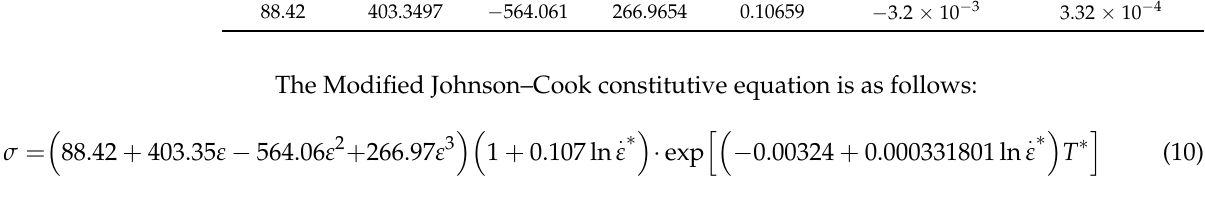
(cid:0) +B ε +B ε 2 +B ε 3 (cid:3439) and ln ε (cid:4662) * at A 1 + B 1 ε + B 2 ε 2 + B 3 ε 3 Figure 5. Relationship between: ( a ) σ and ε at 1123 K and 1 s − 1 ; ( b ) σ / 1 1 2 3 (cid:20) σ . ∗ σ (cid:3432) and T * at 1 s - 1 ; ( d ) λ and ln ε (cid:4662) * . ε and ln at the temperature of 1123 K; ( c ) ln ( A 1 + B 1 ε + B 2 ε 2 + B 3 ε 3 ) ( 1 + C 1 ln . ε ∗ ) (cid:4666) A 1 + B 1 ε + B 2 ε 2 + B 3 ε 3 (cid:4667)(cid:3435) 1+ C 1 ln ε (cid:4662) * (cid:3439)